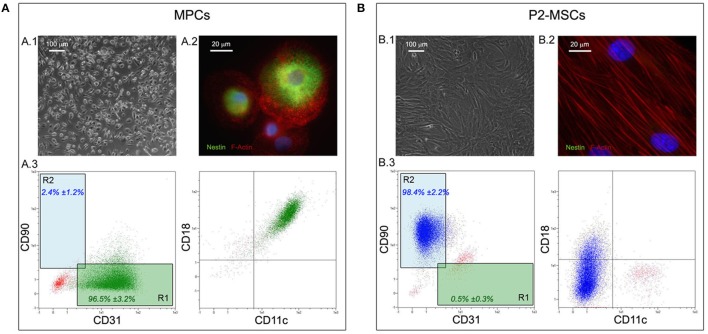
Isolation and characterization of hBM-derived MPCs. Culturing hBM-MNCs for 6 days under MPC selective conditions lead to almost homogenous population of rounded and highly rifrangent adherent cells (A.1). These cells were definitively characterized as MPCs for their intense positivity to nestin (green in A.2) and for the presence of numerous podosome-like structures characterized by the dotted distribution of F-Actin (red in A.2). Flow cytometry confirmed the MPC phenotype on approximately all analyzed cells (A.3), which were displayed in the lower right quadrant of the CD90 vs. CD31 dot-plot (“R1” green box). After two passages under mesengenic differentiating conditions (P2-MSCs) the cultures were constituted by proliferating and fibroblastoid MSC-like cells (B.1) and nestin was no longer detected (B.2). All MPC-related markers resulted undetectable by flow cytometry on P2-MSCs (B.3), which expressed high levels of CD90, occupying the upper left quadrant of the CD90 vs. CD31 dot-plot (“R2” blue box).